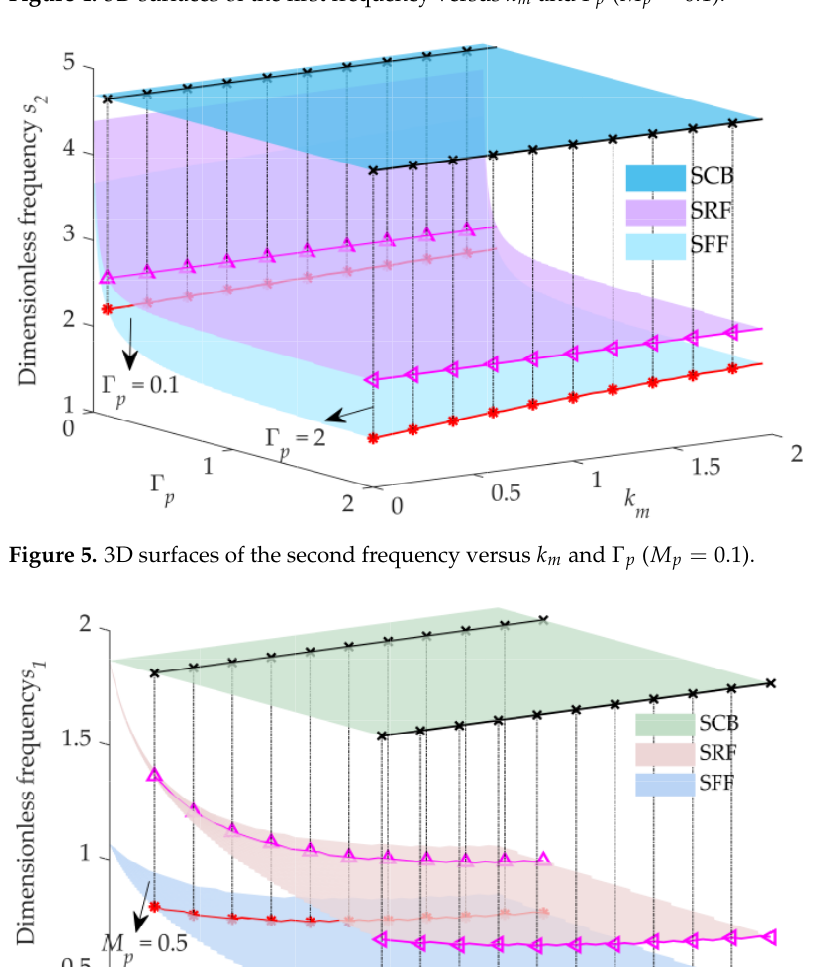
Figure 4. 3D surfaces of the first frequency versus k m and Γ p ( M p = 0.1).